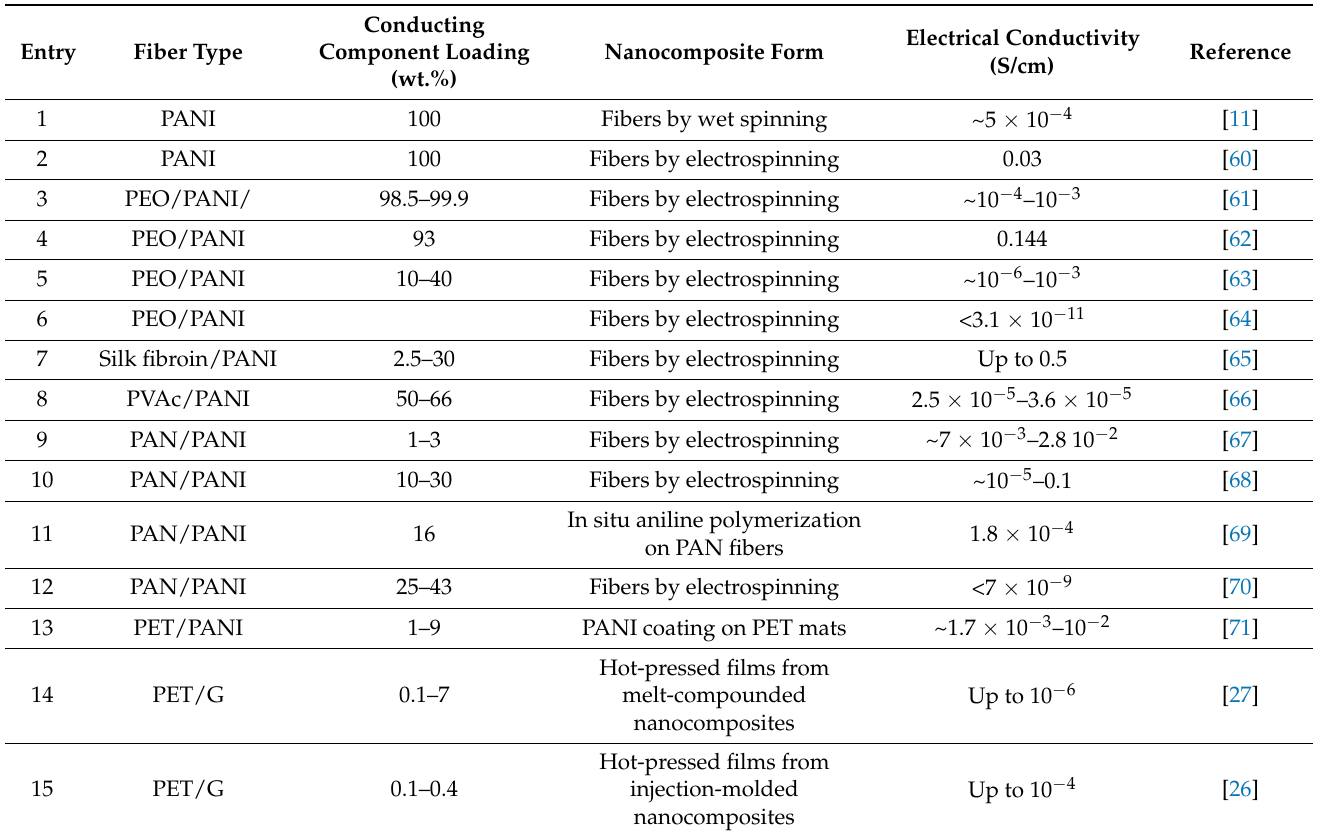
Table 3. Comparison of the electrical conductivity of different conductive